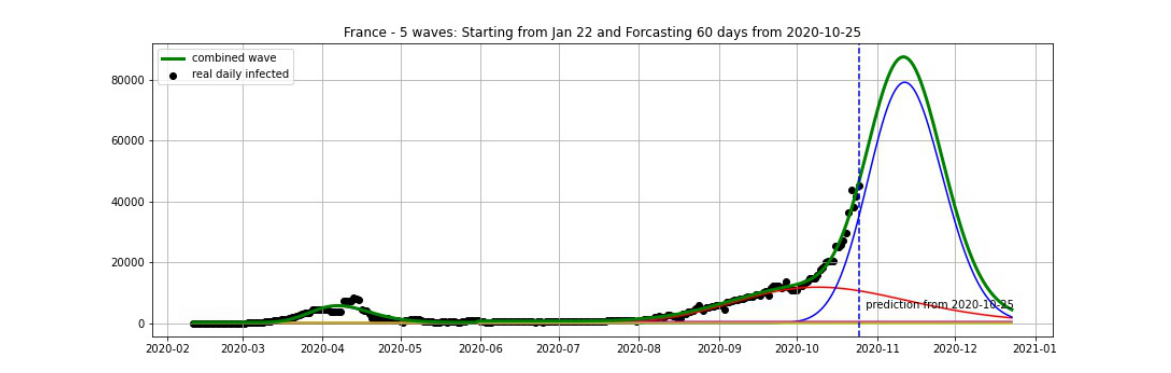
Figure 5. France: fitting and forecasting from 25 October with 5 wavelets. Our model predicts a new wave starting from October